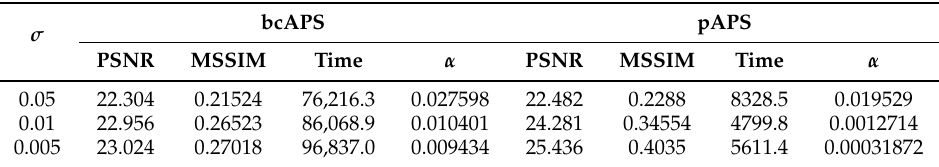
Table 15. PSNR- and MSSIM-values of the reconstruction of the cameraman-image corrupted Gaussian blur and Gaussian white noise with standard deviation σ via the bcAPS algorithm using the primal-dual Newton method with η =